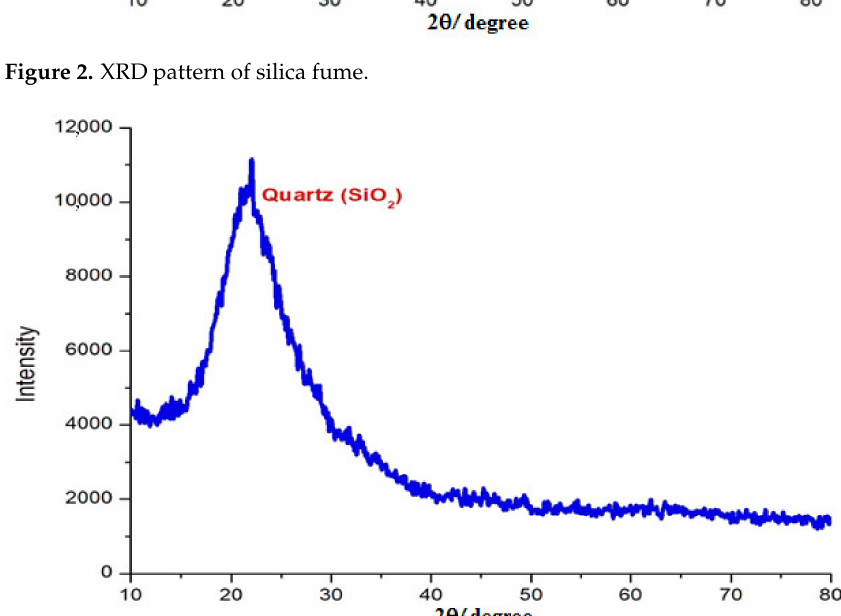
Figure 3. XRD pattern of rice husk ash.